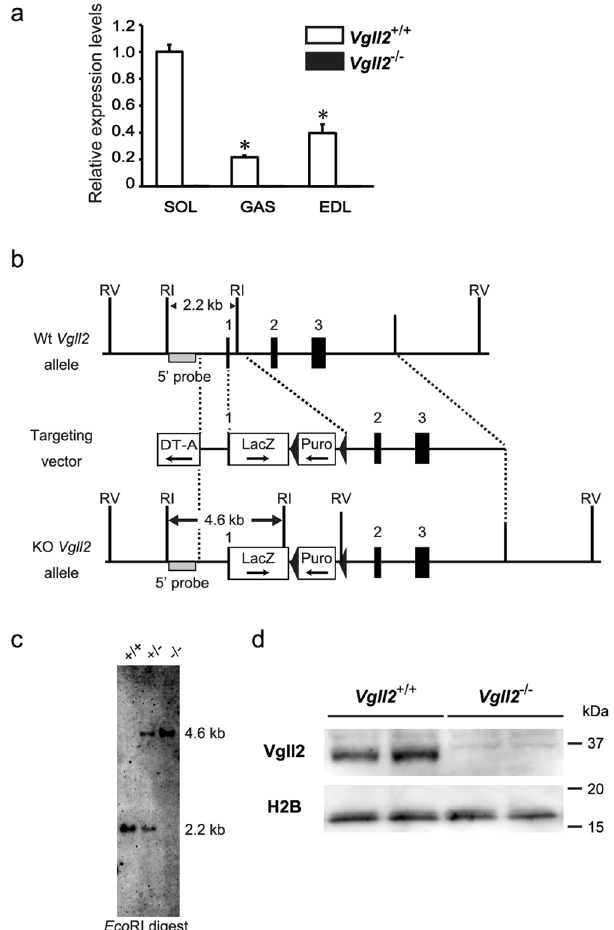
Figure 1. Expression patterns of Vgll2 mRNA expression in several muscles, and generation of Vgll2-deficient mice. ( a ) Vgll2 mRNA levels were measured by qPCR in the soleus (SOL), gastrocnemius (GAS), and extensor digitorum longus (EDL) muscles from 12-week-old Vgll2 + / + and Vgll2 − / − mice (n = 6). * P < 0.05 vs. Vgll2 + / + soleus muscles. Data are presented as mean ± SEM. For comparison, the expression level in Vgll2 + / + soleus was arbitrarily set at 1. ( b ) Schematic diagram showing the strategy used to generate the Vgll2 null allele. The top row depicts the wild-type Vgll2 allele, which consists of three exons ( solid boxes ). The initiation Met codon for Vgll2 exists in exon 1. The second row depicts the targeting construct. The third row depicts the mutated Vgll2 allele. The lacZ expression cassette with a SV40 polyadenylation signal, which was followed by the loxP-flanked puromycin resistant gene expression cassette (Puro) in the reverse orientation, was fused to the initiation codon of Vgll2 . The diphtheria toxin A expression cassette (DT-A) was included at the 5 ′ -end of the targeting vector. The external probe used for Southern blot analysis lies outside the 5 ′ -homologous arm ( gray box ). RI, Eco RI; RV, Eco RV. ( c ) Southern blot analysis for genotyping wild-type ( Vgll2 + / + ), heterozygous Vgll2-deficient ( Vgll2 + / − ), and homozygous Vgll2-deficient ( Vgll2 − / − ) animals. Digestion with Eco RI of Vgll2 + / + and Vgll2 − / − alleles gave rise to fragments of 2.2 and 4.6 kb, respectively. An uncropped original image is shown in Supplementary information. ( d ) Vgll2 protein levels were assessed by Western blotting using nuclear protein extracts obtained from the soleus muscle of 12-week-old Vgll2 + / + and Vgll2 − / − mice. Histone H2B served as a loading control. Analyses were performed on four mice per genotype. Data from two mice per genotype are shown. Uncropped original images are shown in Supplementary